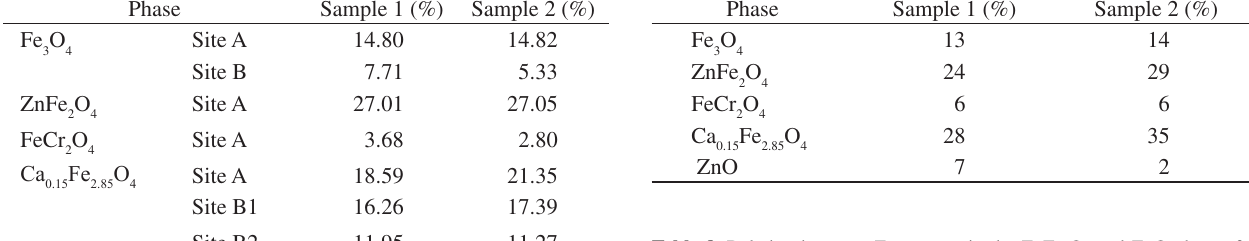
O a�d Z�O phases �or 2 4